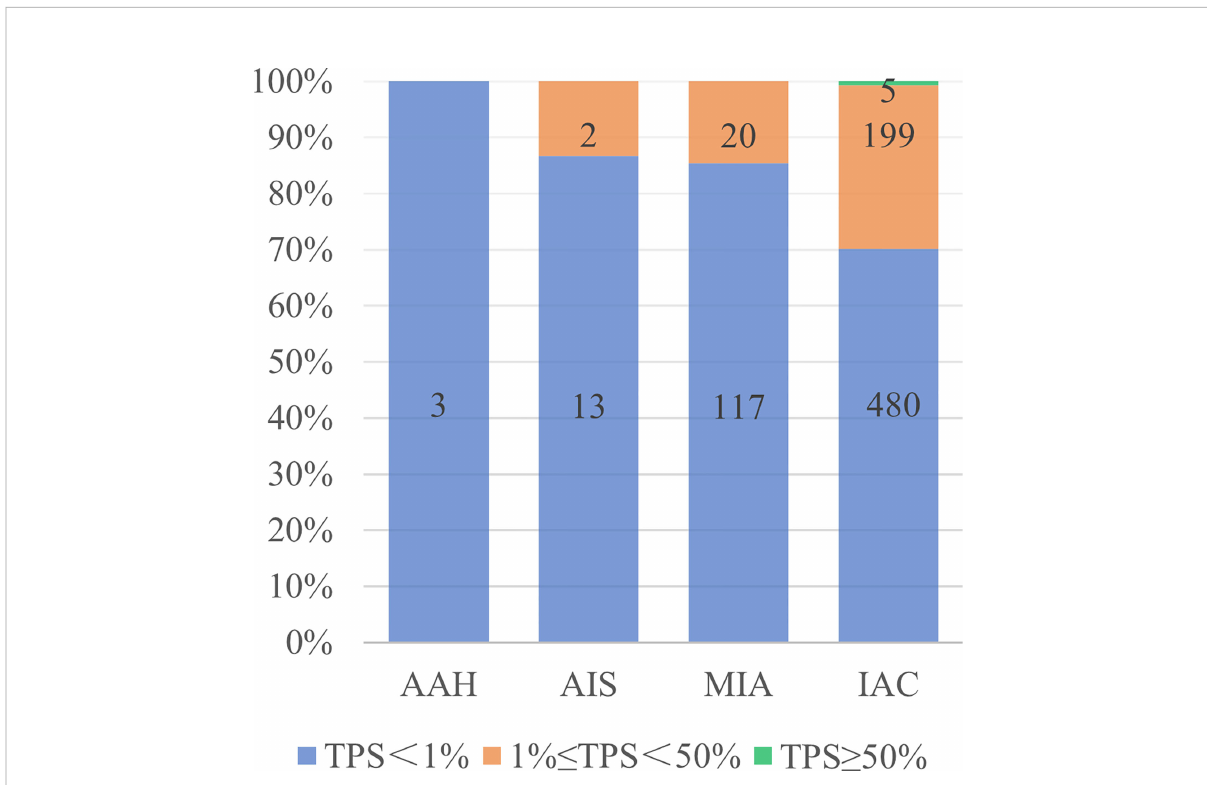
FIGURE 2 PD-L1 expression in different pathological types of lung adenocarcinoma. AAH, atypical adenomatous hyperplasia; AIS, adenocarcinoma in situ; MIA, microinvasive adenocarcinoma; IAC, invasive adenocarcinomas; TPS, tumor proportion